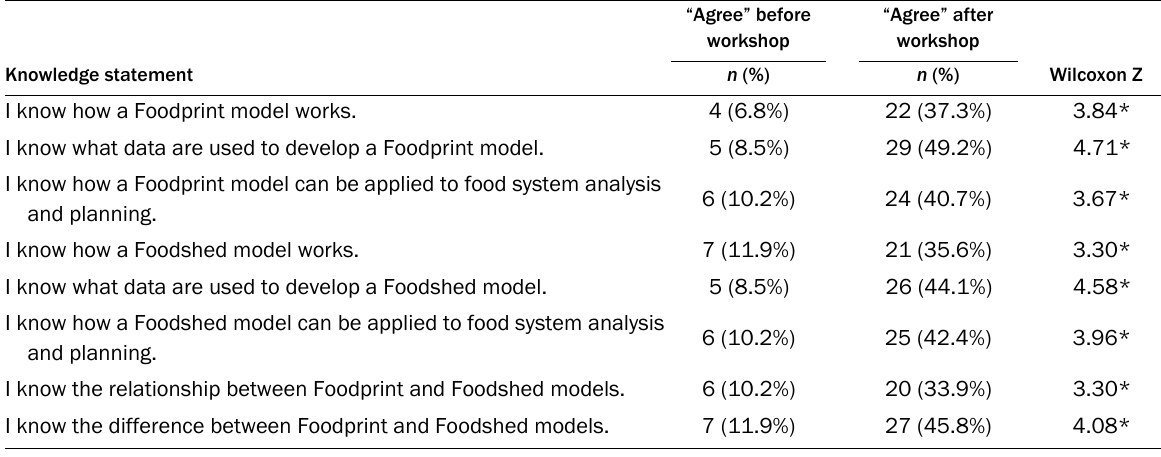
Table 2. Retrospective Pre/post Workshop Survey Responses a